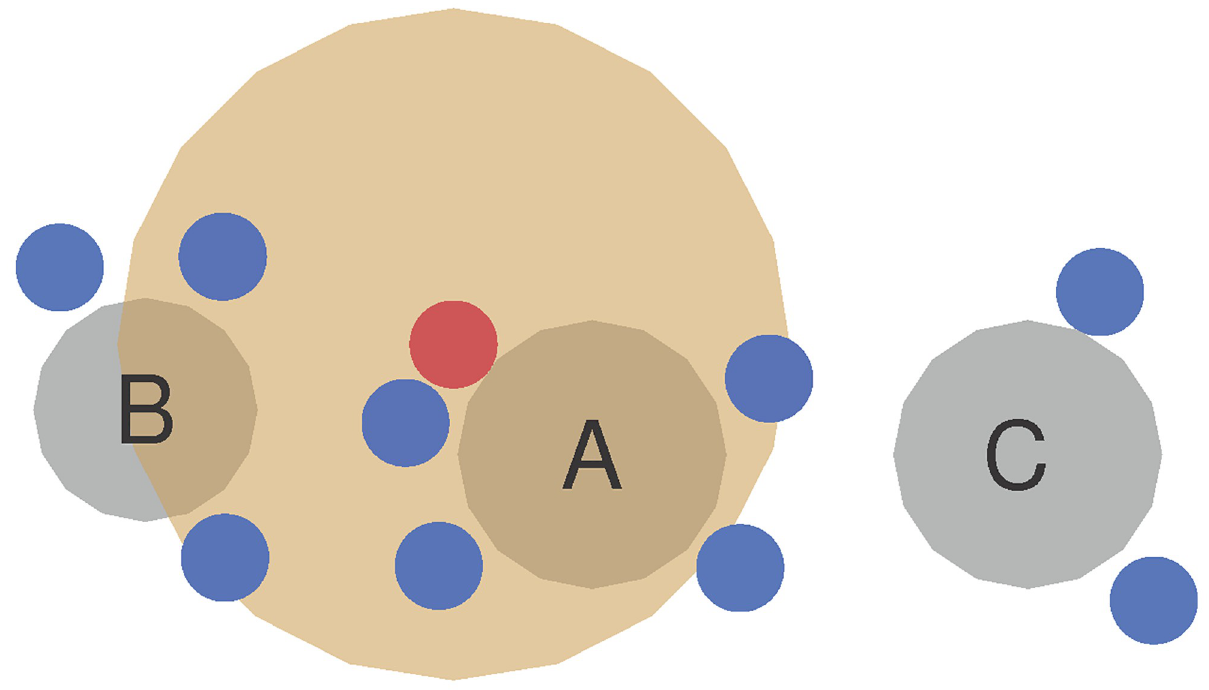
Fig 6. Restaurant scenario. Model of restaurant topography, including tables and seats, according to the seating chart in [48]. Susceptible (blue) persons sit in groups A, B and C around the tables (grey). The infectious (red) person emits aerosol clouds (orange).